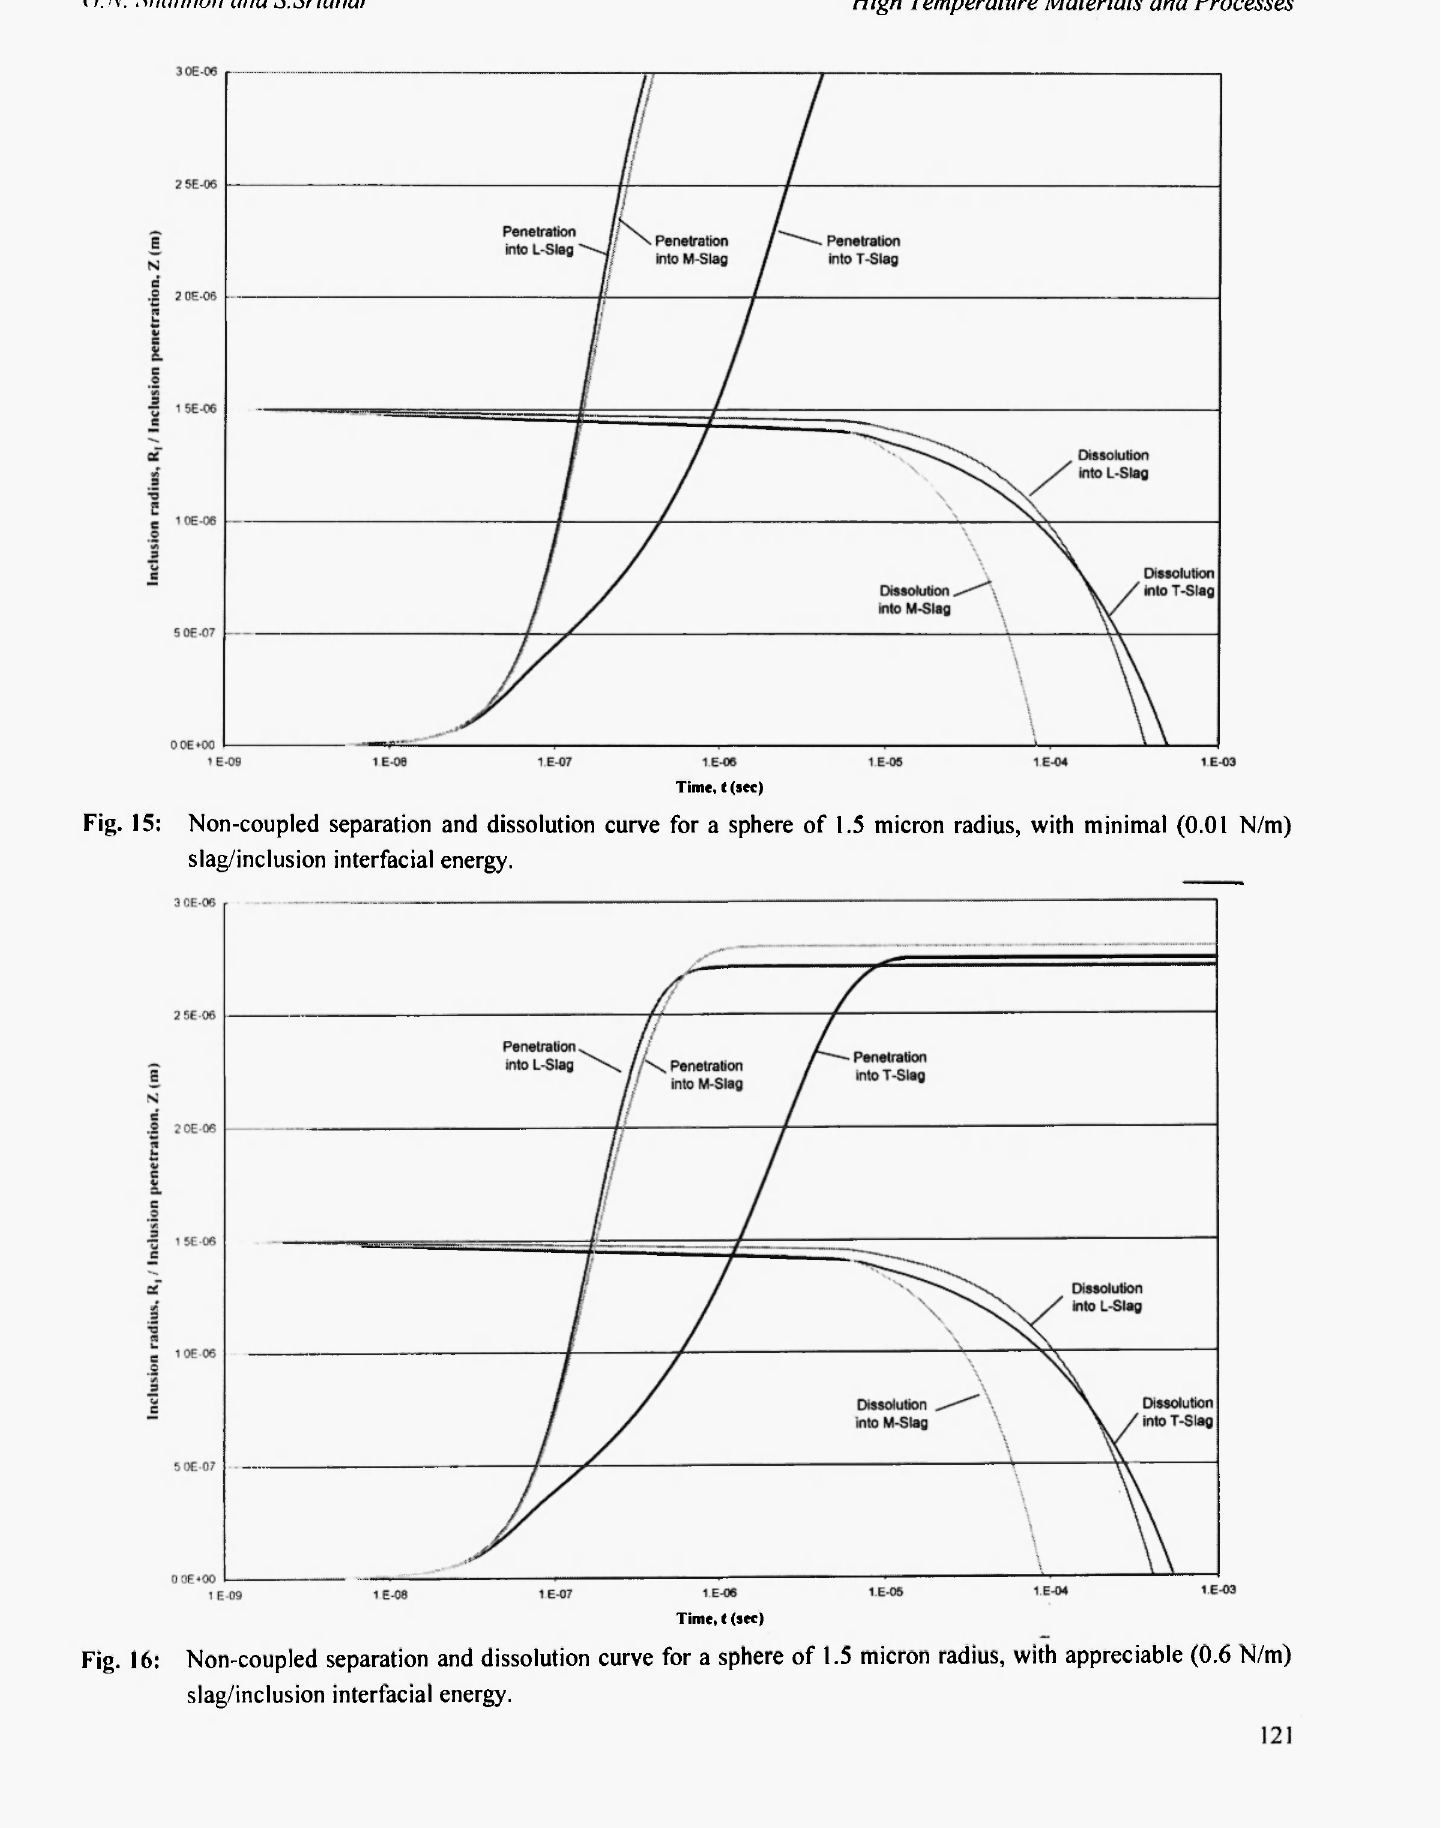
Fig. 16: Non-coupled separation and dissolution curve for a sphere of 1.5 micron radius, with appreciable (0.6 N/m) slag/inclusion interfacial